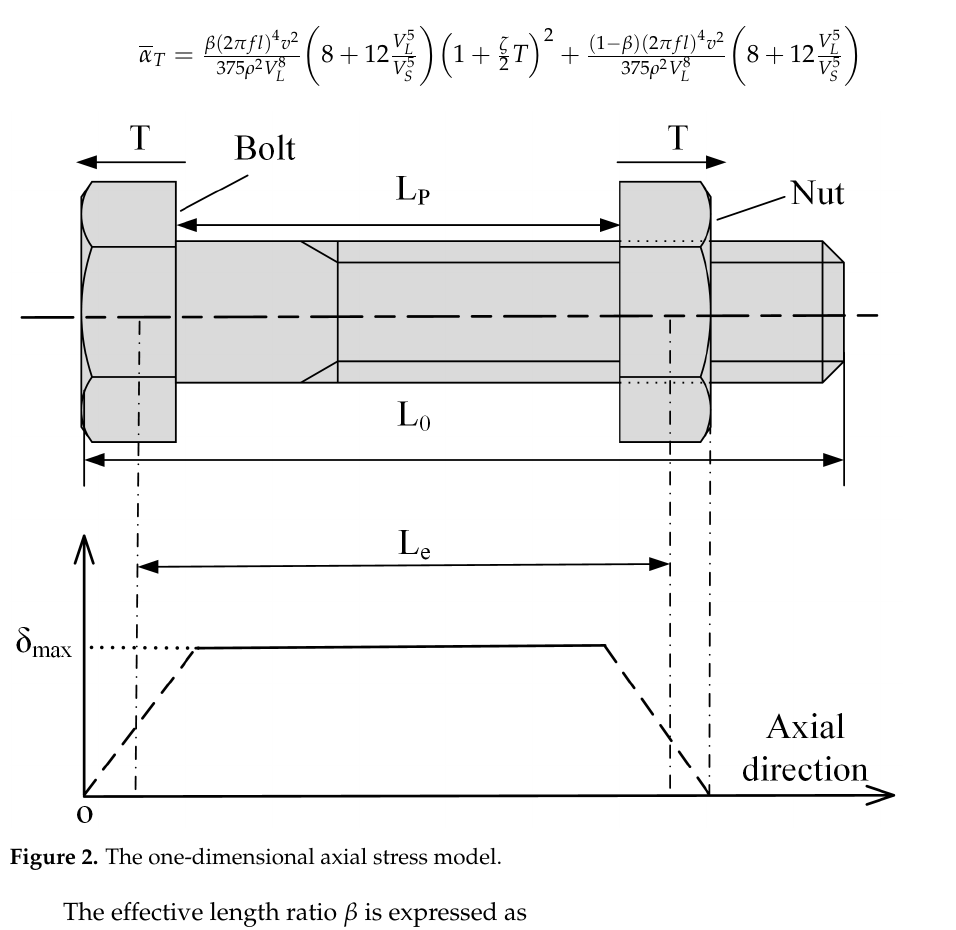
Figure 2. The one-dimensional axial stress model.